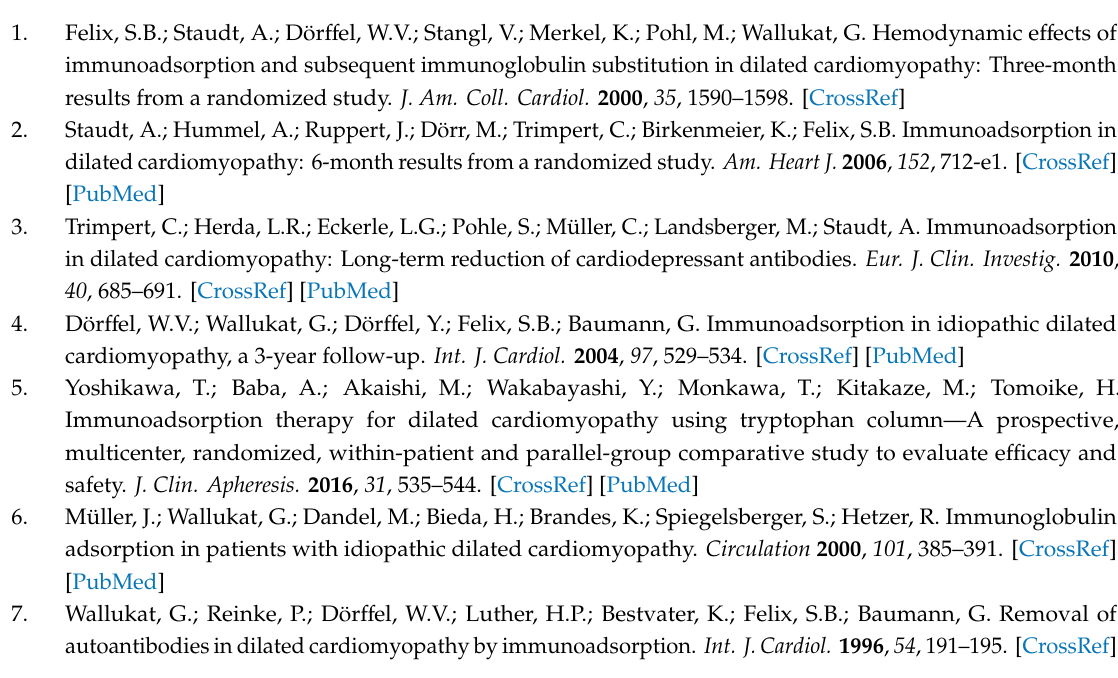
Figure S1: Drop of circulating IgG levels during immunoadsorption treatment., Table S1: Heart failure medication. Table S2: Correlation of ∆ HF biomarker with